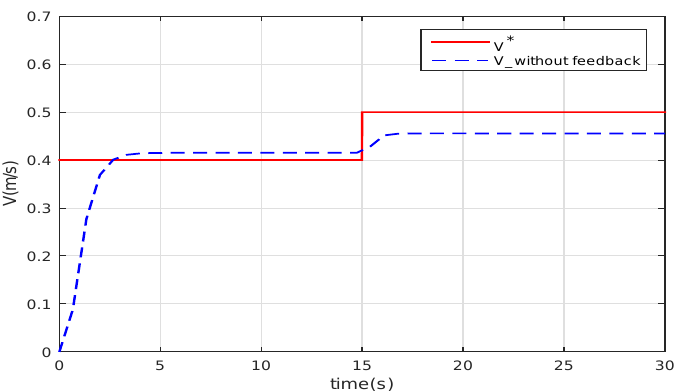
Figure 5. The forward speed of robotic fish without speed feedback.